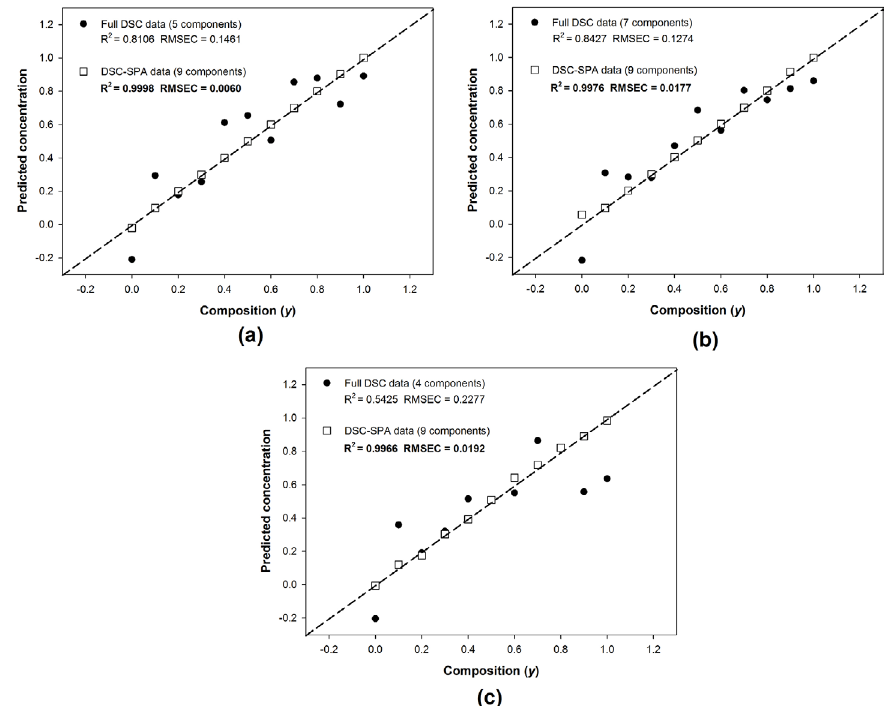
Figure 3. DSC results. Generalized correlation for the calibration samples after applying the PLS with mean- centered preprocessing and full LOOCV. a) No derivative mode. b) First-derivative mode. c) Second-derivative